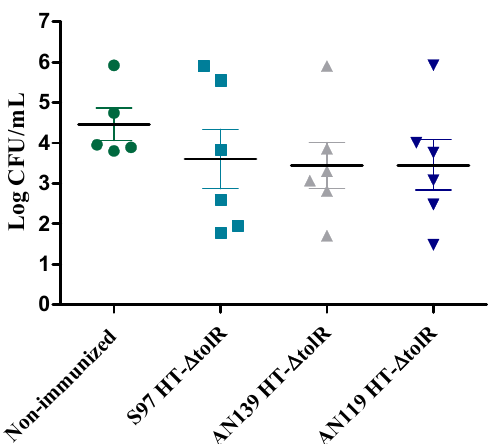
Figure 6. Protection against colonization of Shigella flexneri . Mice were immunized with one single dose of 200 μ g of the antigenic complex HT - ∆ tolR embedded in in different formulations of Gantrez ® MNs (six mice per group). A non-immunized group was included as control. Results are presented as degree of colonization (Log CFU/mL) in lungs. Error bars represent SD.